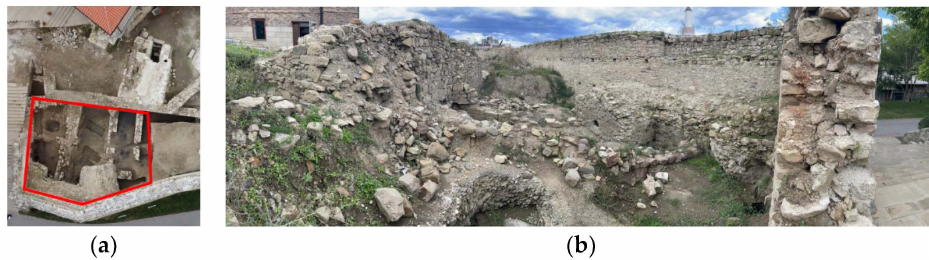
Figure 11. Excavation of the dungeon. ( a ) Aerial view of the site. ( b ) Present state of the remains of the dungeon (Photo source: Lejla